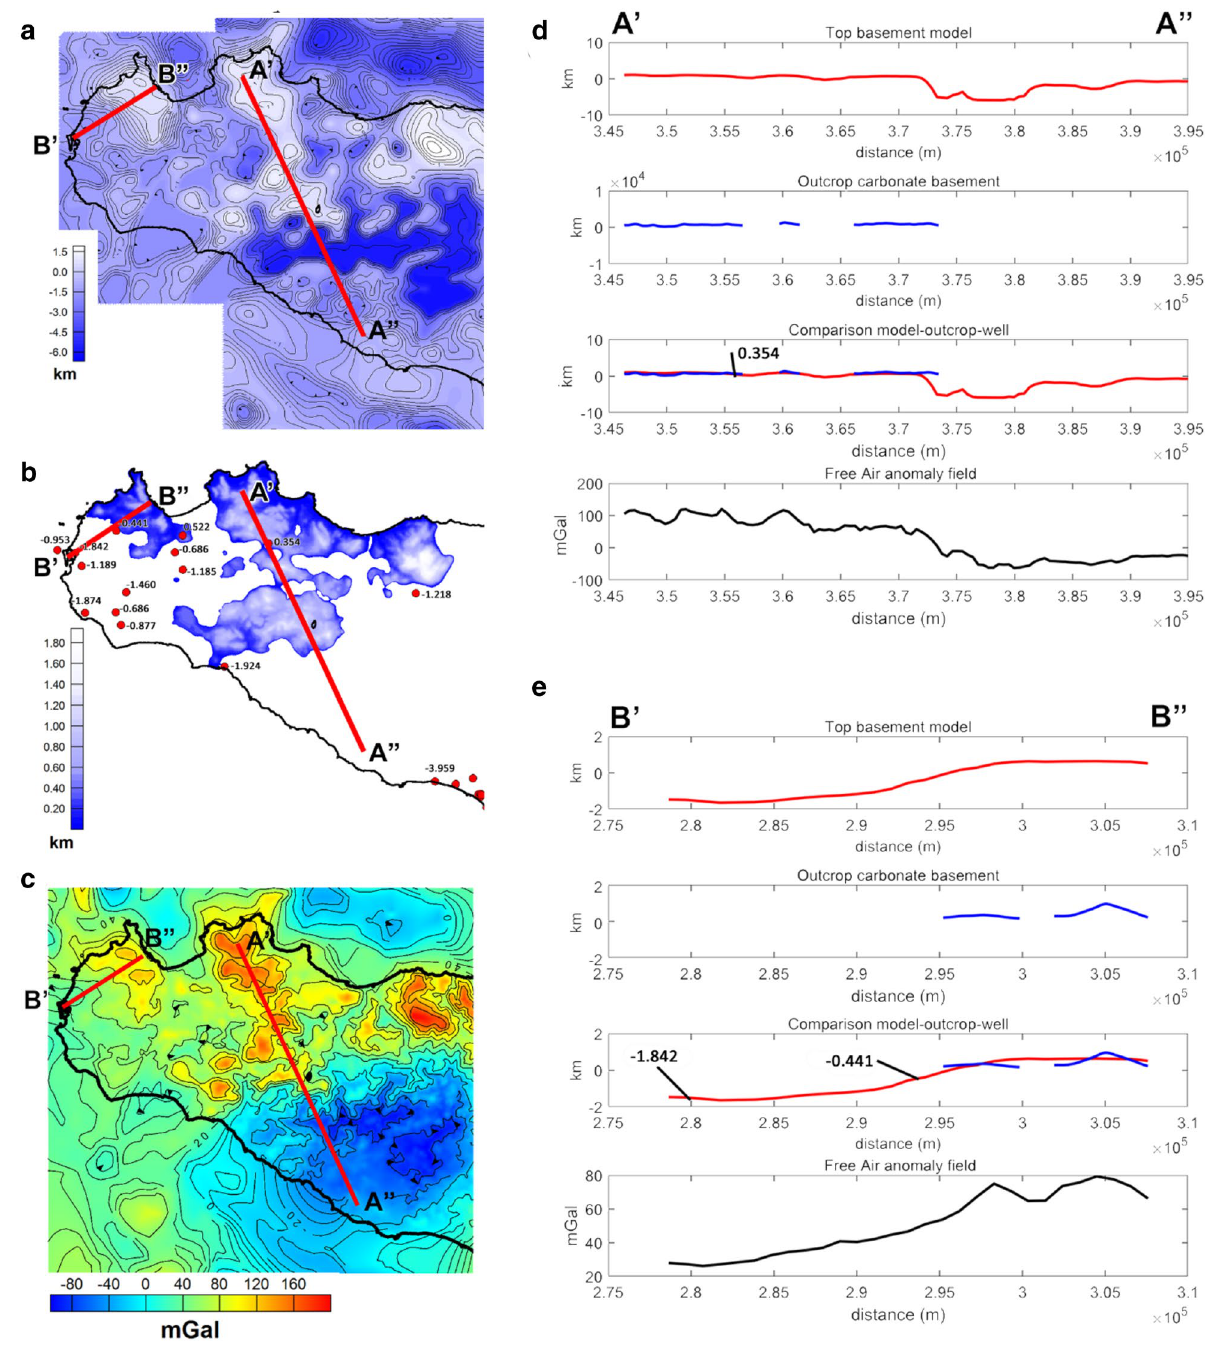
Figure 6. Localization of profiles A’A” and B’B” on the carbonate top surface map represented with carbonate basement depths relative to the well logs ( a ), the outcrop Mesozoic carbonate map ( b ), and the Free Air gravity map ( c ); Comparison between the model profile A’A” ( d ) and B’B” ( e ) with wells, outcrop data, and Free-air anomaly data along the same up to 100 mW/m 2 (e.g. 4 ), which well correlates with the computed shallow Curie temperature isotherm. Other seismic and gravimetric studies of crustal structure also revealed a shallow thickness of about 20 km beneath the Sicily channel, gradually thickening toward the Sicilian coast (e.g. 38,84,85 ). Shallow depths (~ 12 km) are observed beneath the southeastern part of the Tyrrhenian Sea, which indicates a rising of Curie temperature isotherm (Fig. 8b). This shallow Curie temperature isotherm corresponds to high heat flow values, up to more than 100 mW/m 24 . The Moho depth is found to be slightly deeper (20 km) (e.g. 38,100 ). Comparing to other geological and geophysical data, our estimated Curie depth points describe the expected model, where the shape of the isothermal surface is strictly related to the crustal heat flow.